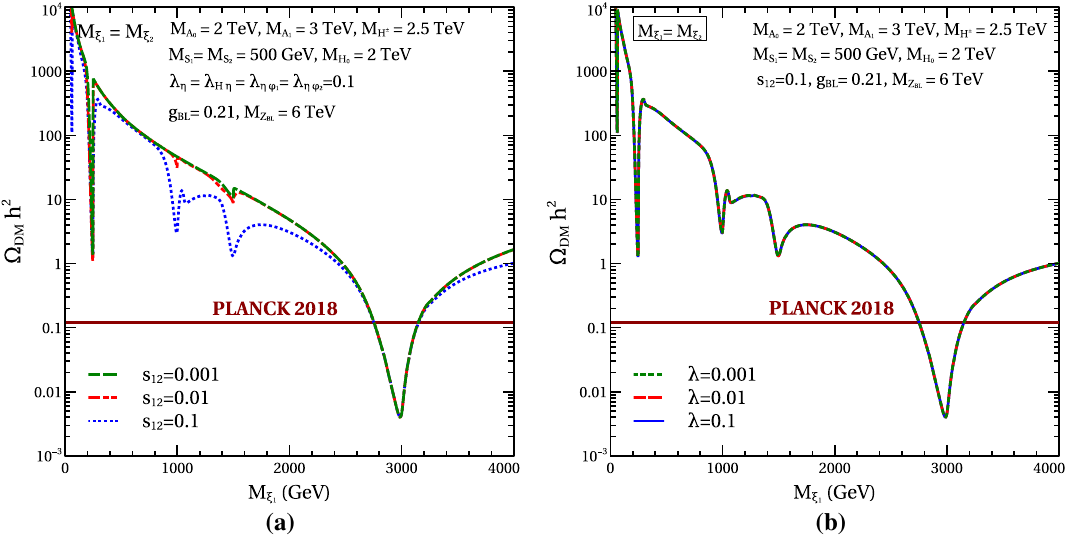
(cid:9) (cid:8) (cid:5) 2 = (cid:5) ξ h 2 + (cid:5) ξ h 2 with degenerate masses M ξ DM h 1 2